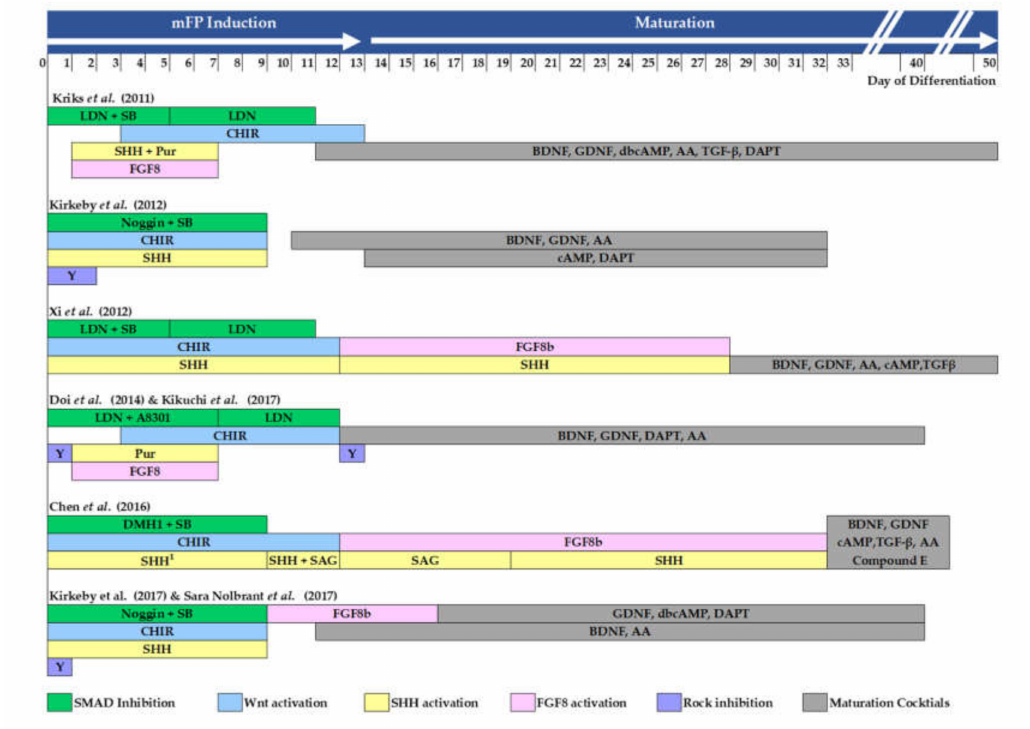
Figure5. Currentapproachestodrivingfloorplatemidbraindopamine(FP-mDA)neurondi ff